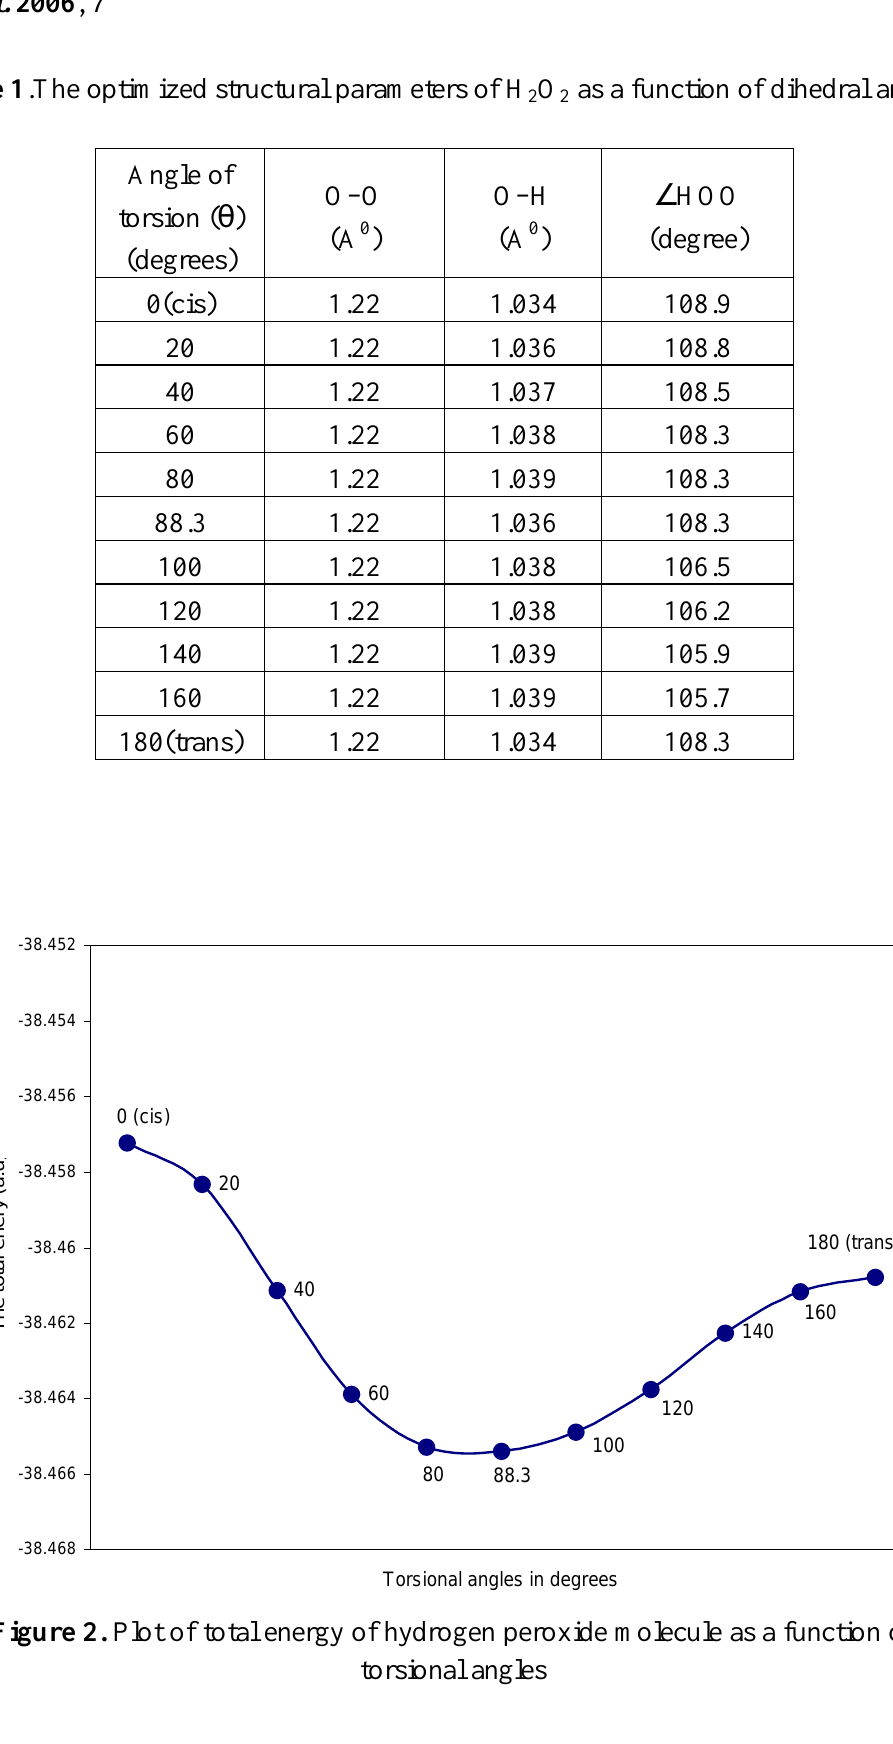
Table 1 .The optimized structural parameters of H